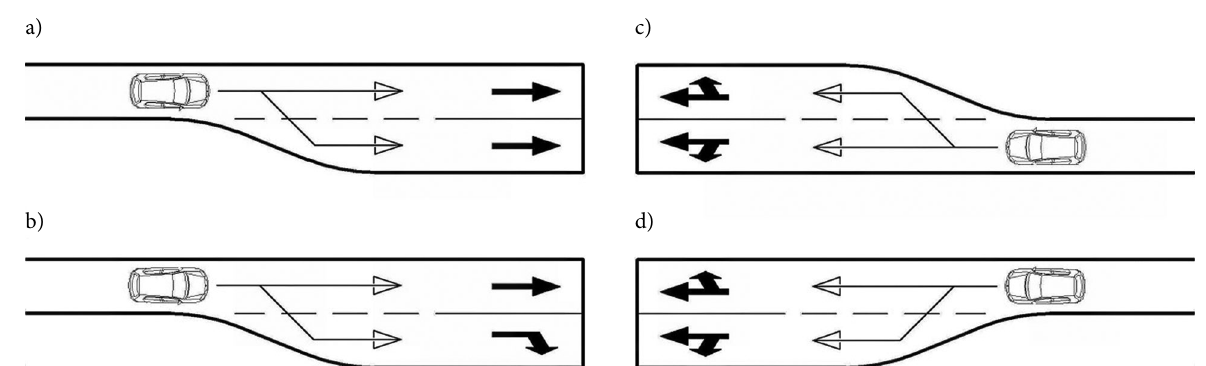
Fig. 1. Schemes of short traffic lanes commonly used in old towns of major